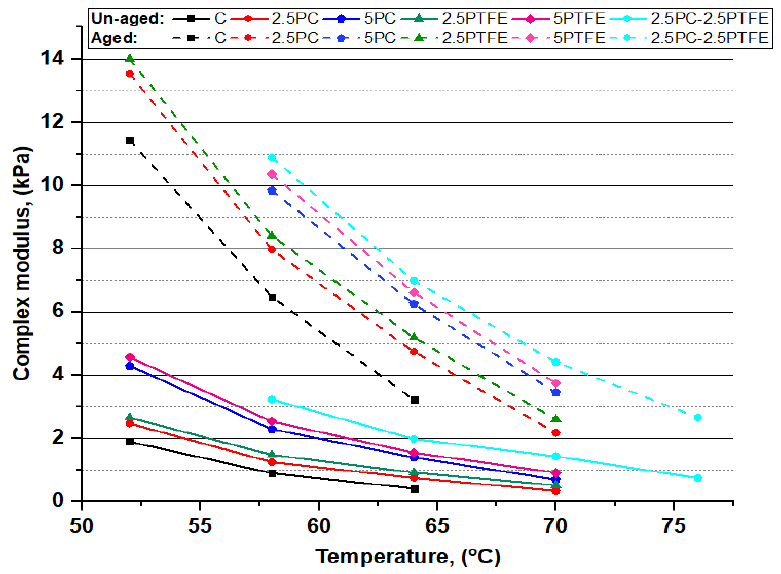
Figure 7. Relationship between complex modulus (G*) and temperature before and after aging.